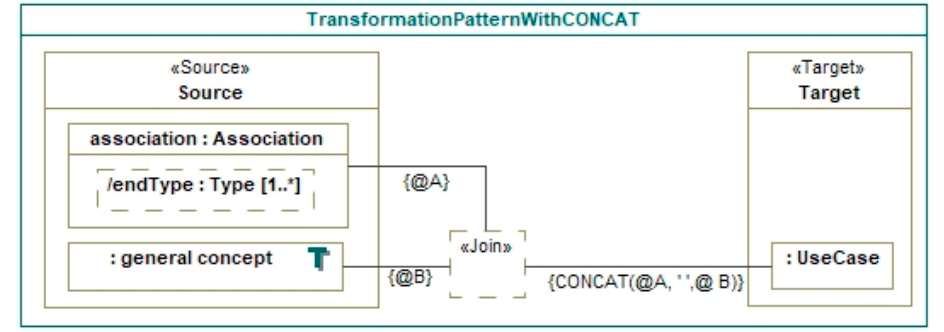
Figure 5. Sample transformation pattern with CONCAT().